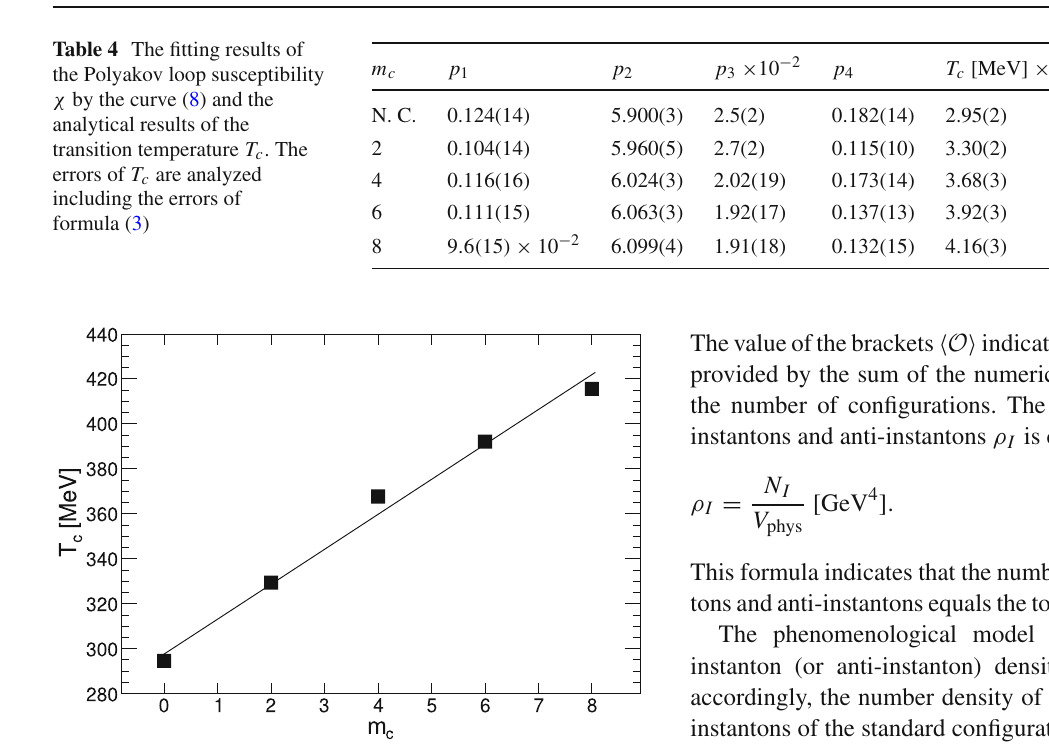
Fig. 5 The rise of the critical temperatures T c with increasing the mag- netic charges m c . The outcome of the magnetic charge m c = 0 is the result of the normal